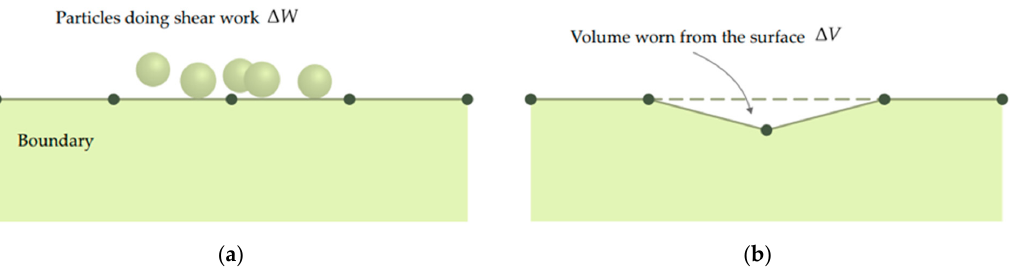
Figure 3. Mechanism of shape change by wear: ( a ) at time t ; ( b ) at time t + ∆ t